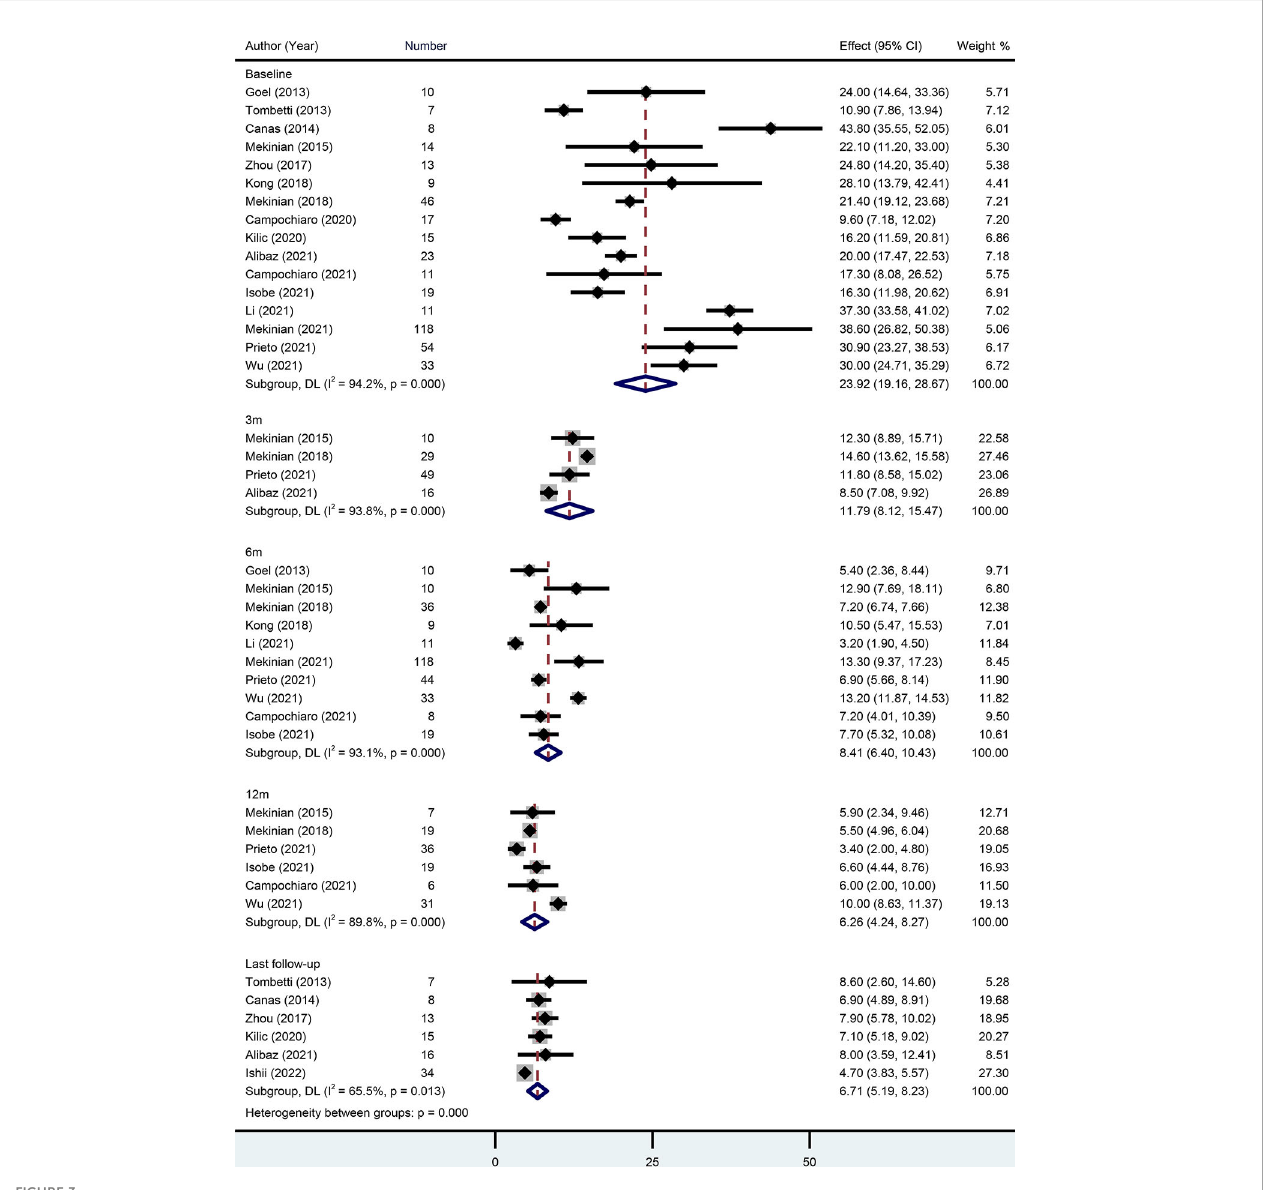
FIGURE 3 Forest plot showing the pooled results of glucocorticoid level at the baseline, 3-month, 6-month, 12-month and last